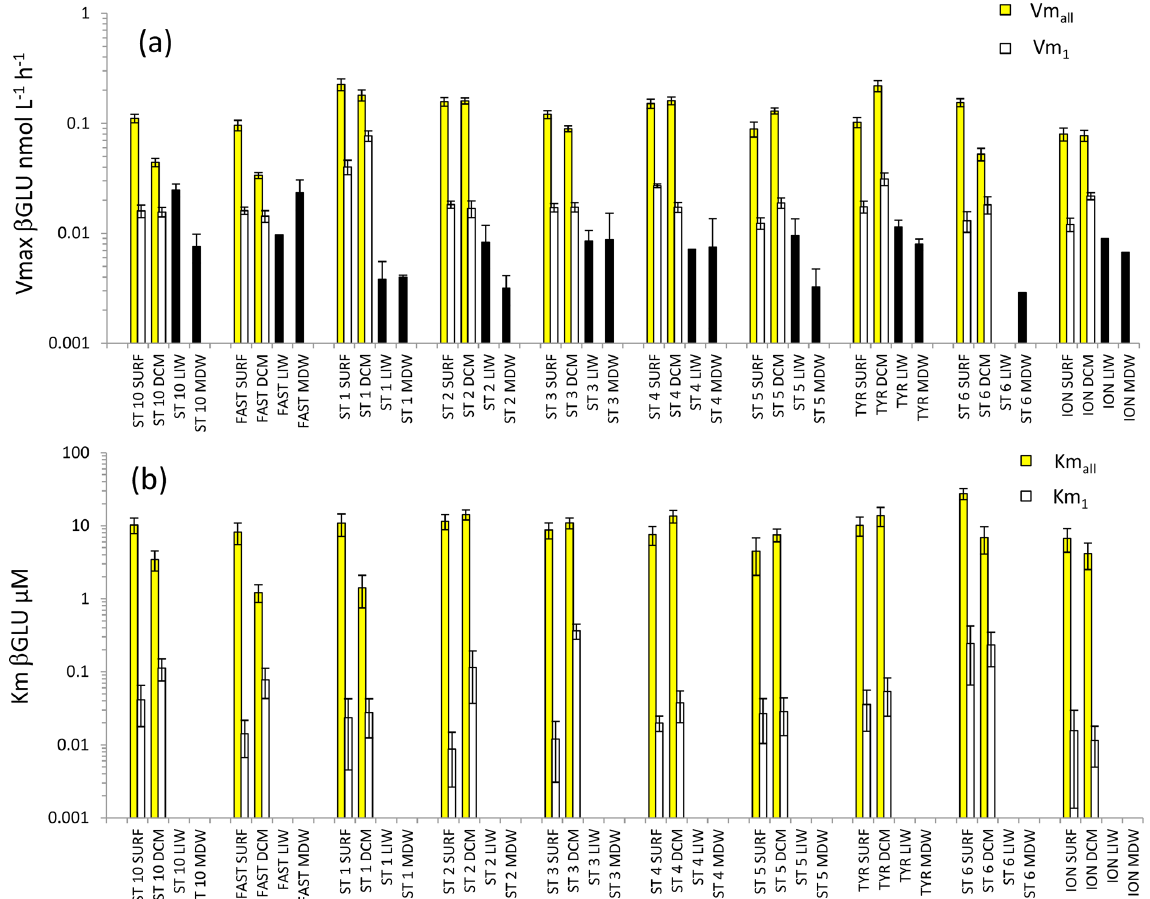
Figure 6. Distribution of kinetic parameters Vm (a) and Km (b) for β -glucosidase ( β GLU) calculated from model 1 (Vm 1 , Km 1 ) and the global model (Vm all , Km all ) in SURF and DCM. Error bars represent the standard errors derived from the nonlinear regressions. In the LIW and MDW layers, kinetics were impossible to compute due to the low number of measurable rates (see results). The black bar in (a) is assumed to represent a minimal value for Vm all